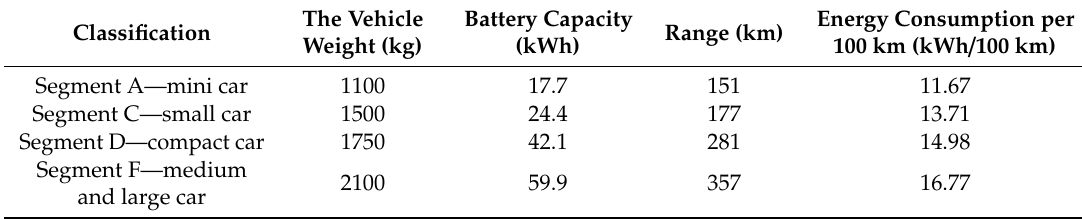
Table 1. Basic parameters of di ff erent levels of electric